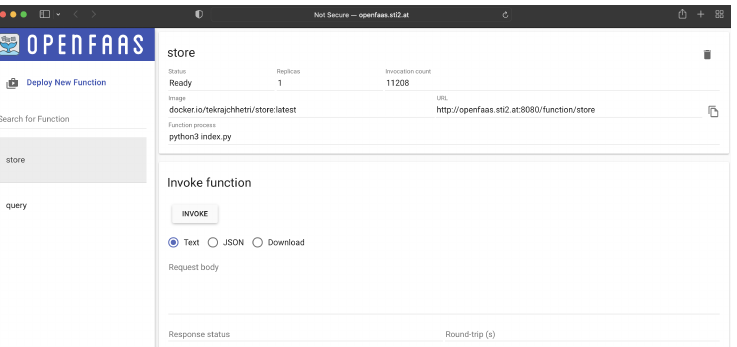
Figure 15. Deployed OpenFaas